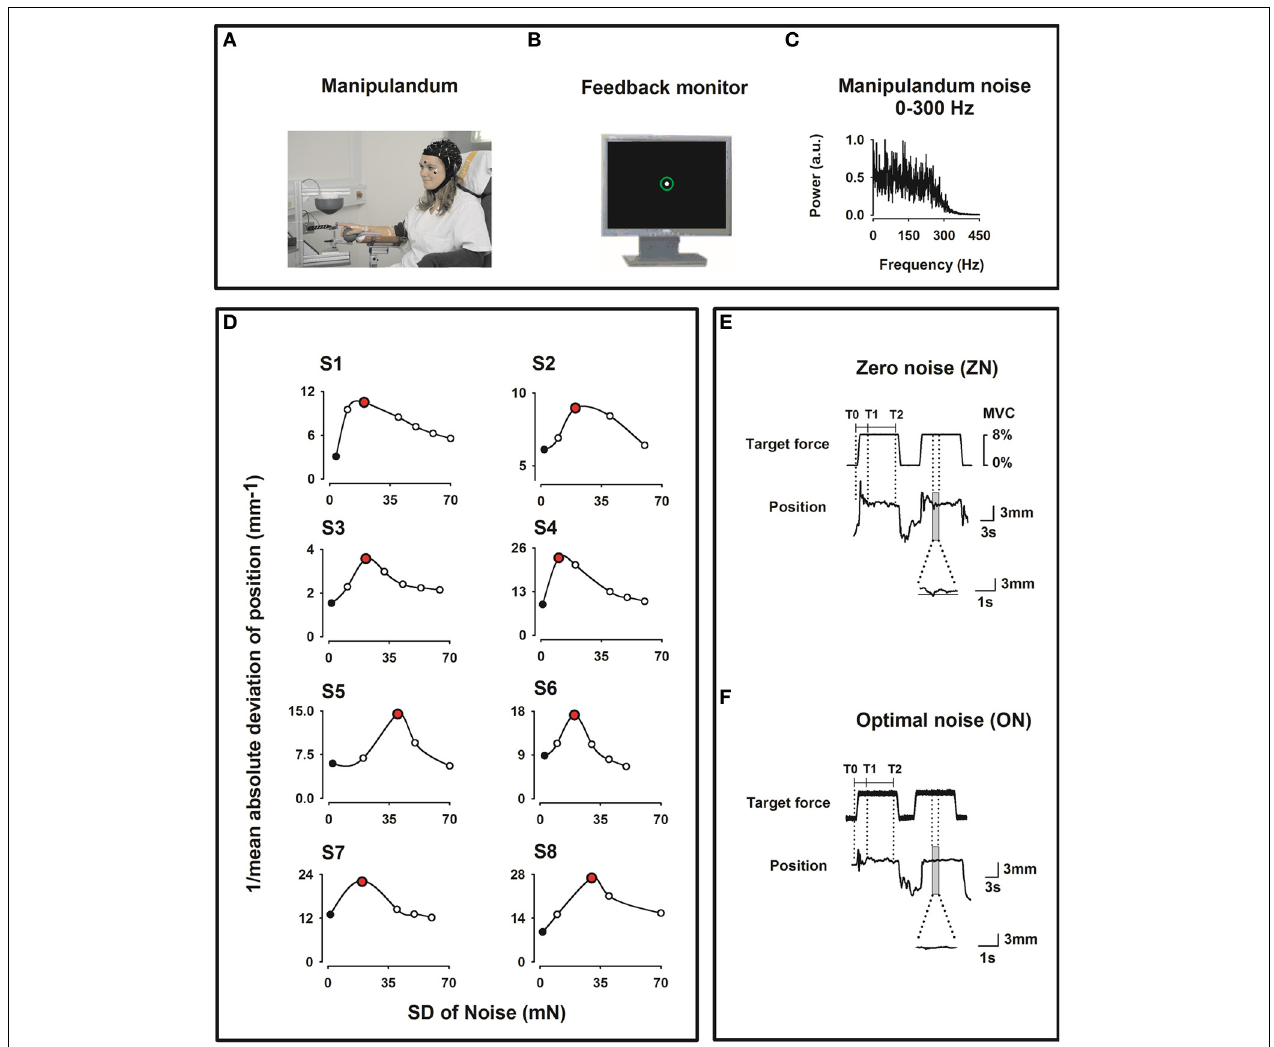
FIGURE 1 | Experimental setup. (A) Home-made index finger manipulandum producing a target static force (8% of individual maximum voluntary contraction) on which noise in the frequency bandwidths 0–300Hz is added. Profile of the target static force in E. EEG (41 channels), electrooculogram (EOG), and EMG from the right first dorsal interosseus (FDI), the right flexor digitoriumsuperficialis(FDS)andtherightextensordigitorumcommunis(EDC) muscles were recorded. (B) Visual feedback of the finger position as a solid white dot within a green circle indicating the tolerance for position errors, displayedonamonitorinfrontofthesubject. (C) Spectralpowerofthenoiseof themanipulanduminarbitraryunits(au)forthe0–300Hzfrequencybandwidth.